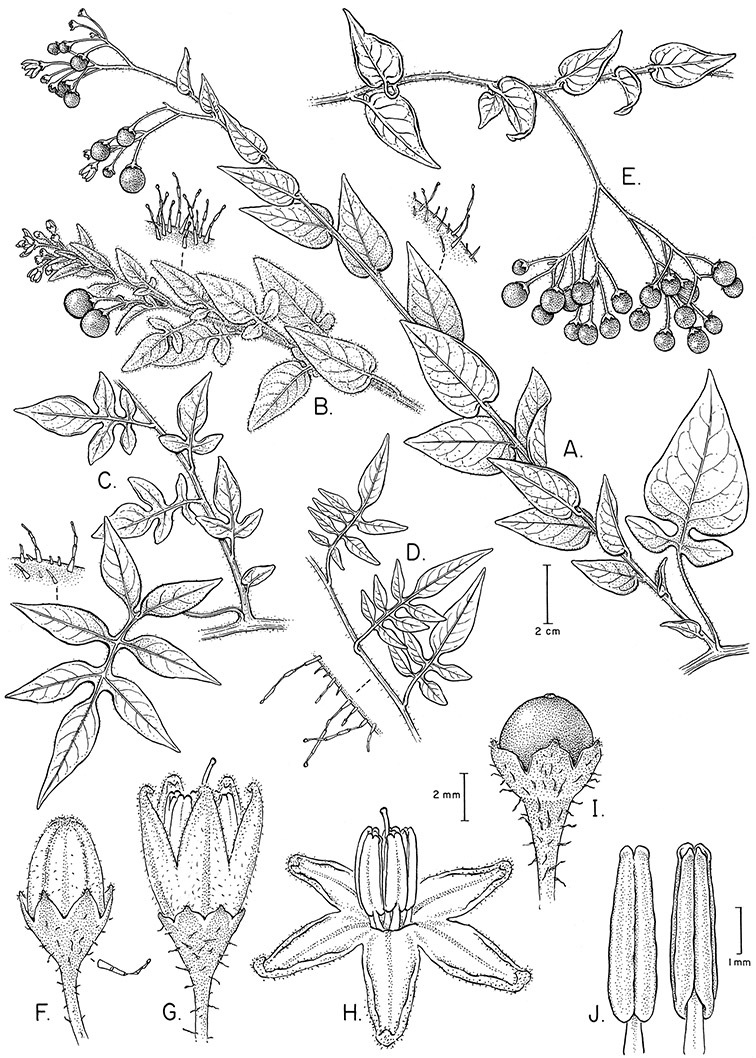
Solanum viscosissimum Sendtn. (A, G, I drawn from Ratter 3430
B drawn from Ribas et al. 1154
C, H drawn from Irwin et al. 11355
D drawn from Irwin et al. 18165b
E, F drawn from Irwin 6221). Illustration by Bobbi Angell.